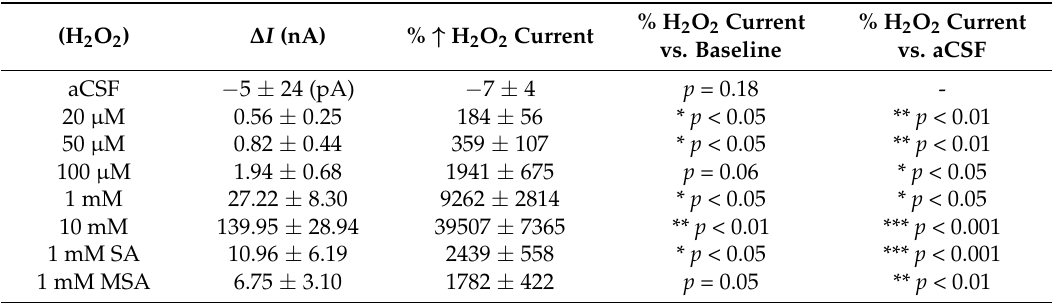
Table 2. Summary of in vivo characterisation data for H 2 O 2 biosensor co-implanted with microinfusion probe in the striatum of anaesthetised NOD SCID